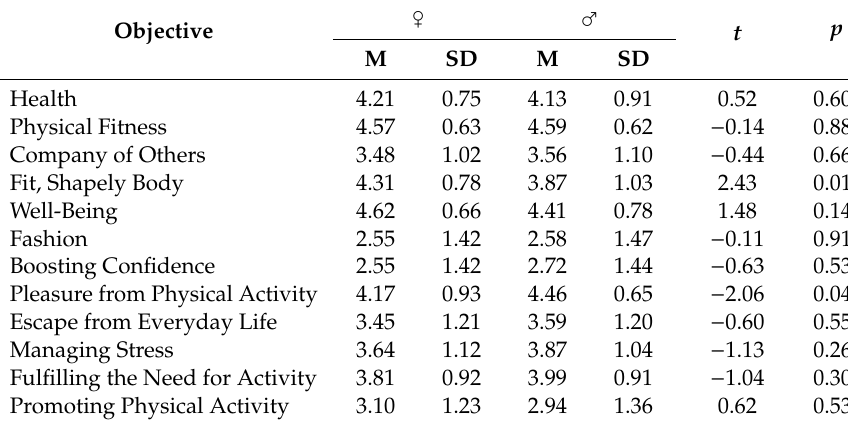
Table 1. Importance of goals of practicing